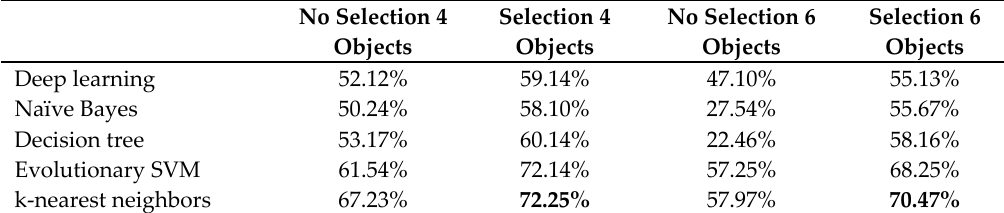
Table 2. Object recognition rate with and without tactile imprints selection for real